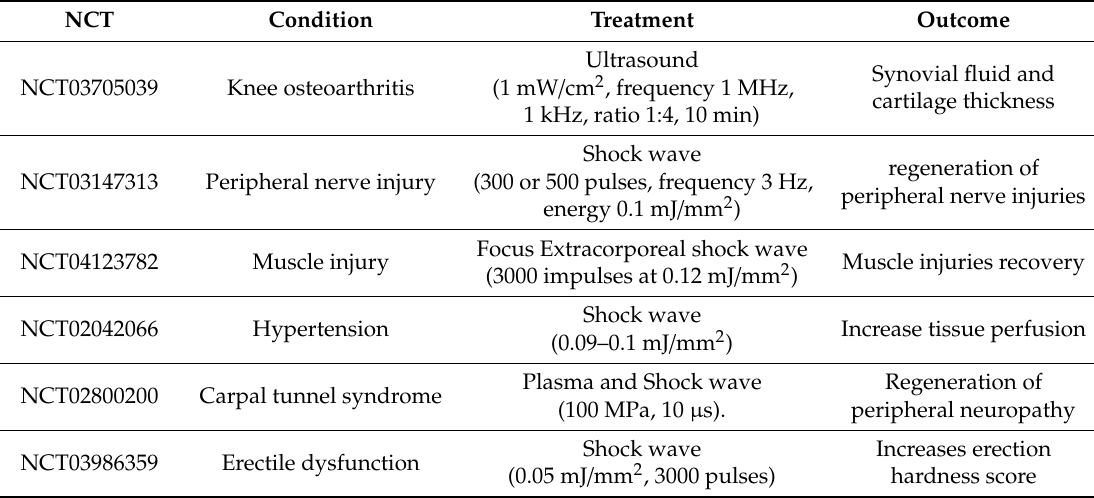
Table 5. Clinical studies carried out for tissue healing with di ff erent ultrasound